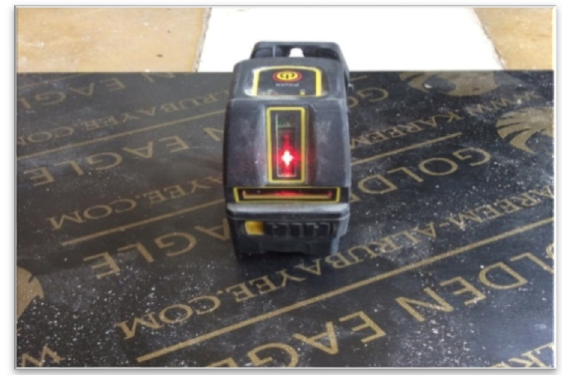
Fig. 2. Two sample of length 50cm. Fig. 3. level